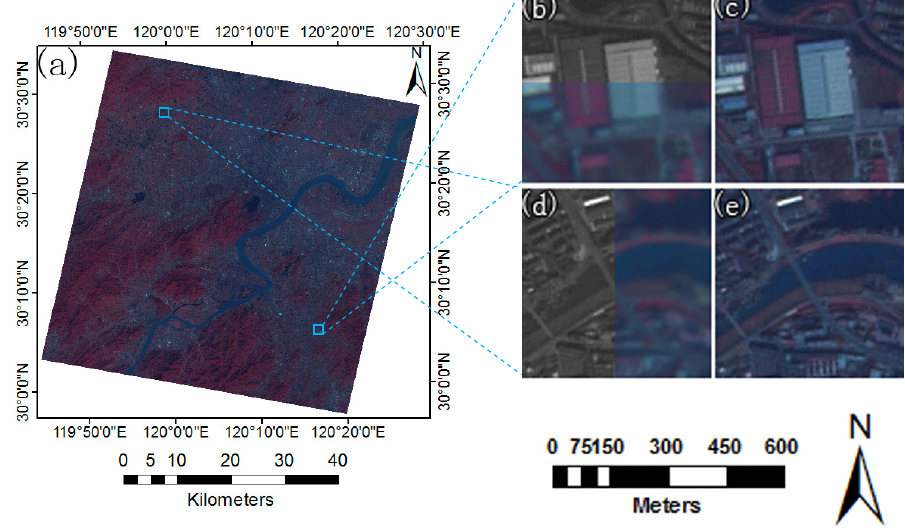
Figure 8. Registration and fusion results of Dataset 2. ( a ) provides an overall view of fused images, ( b ) shows the swipe effect of registered images in the first cyan rectangular area, ( c ) shows the fusion result, ( d , e ) show the result in the second rectangular